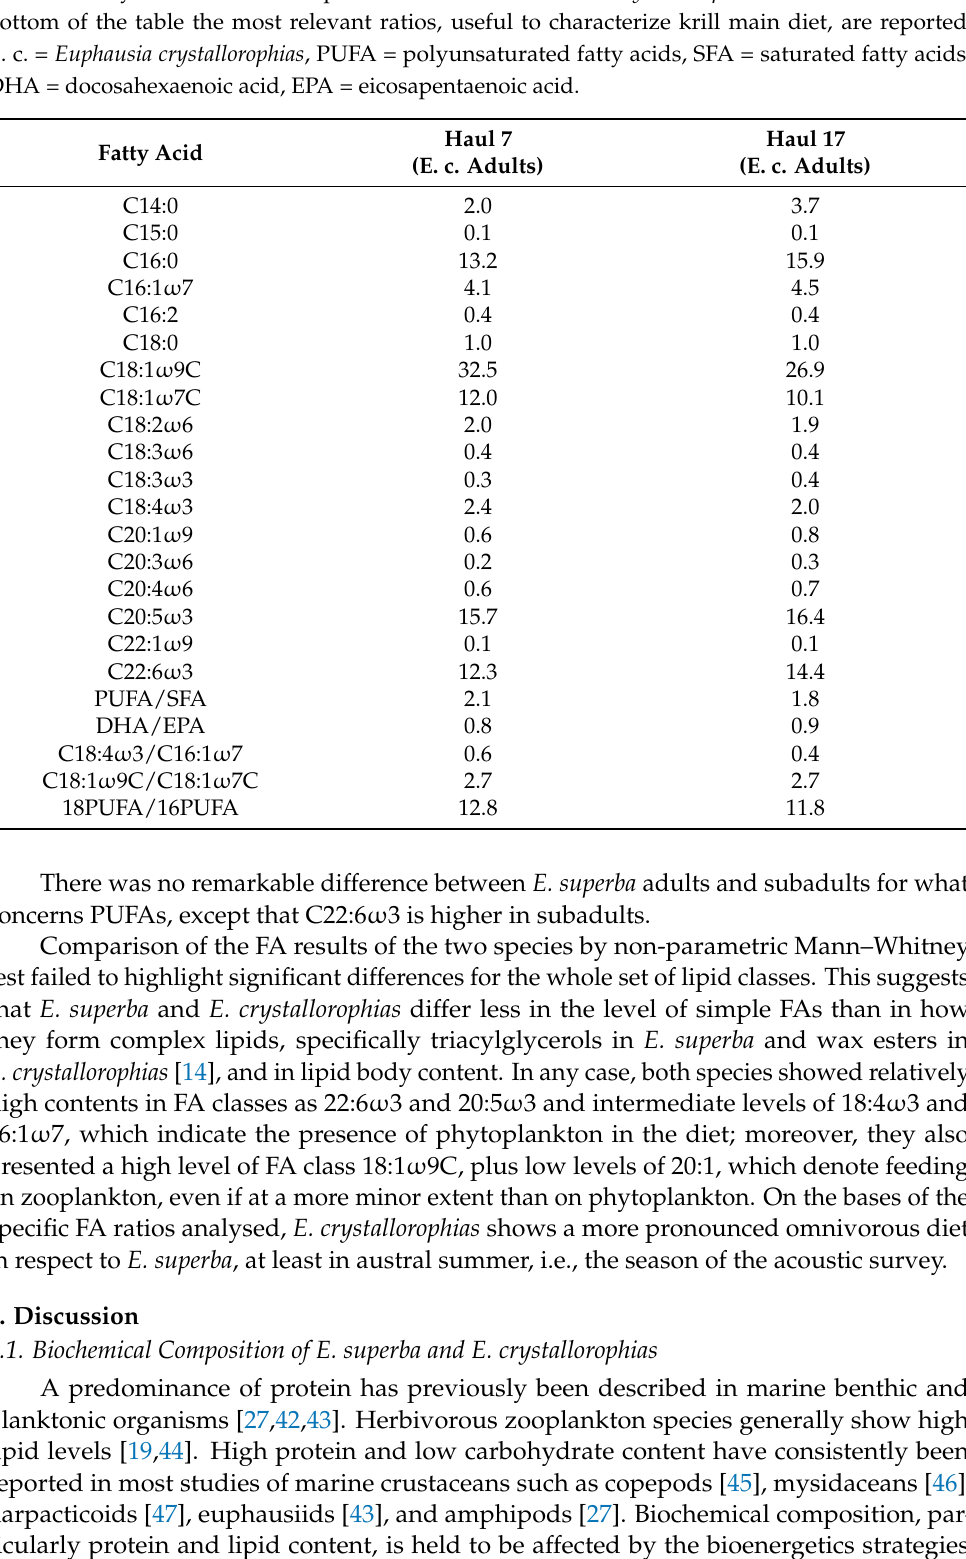
Table 5. Fatty acids classes and percent content found in E. crystallorophias individuals. At the bottom of the table the most relevant ratios, useful to characterize krill main diet, are